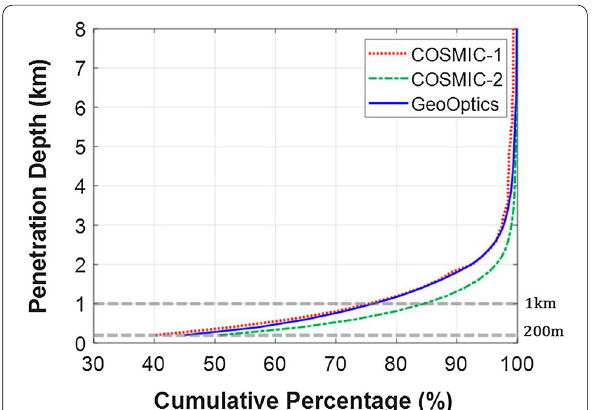
Fig. 3 Penetration percentage versus penetration depth for COSMIC-1 (red dotted curve), COSMIC-2 (green dash-dotted curve) and GeoOptics (blue solid